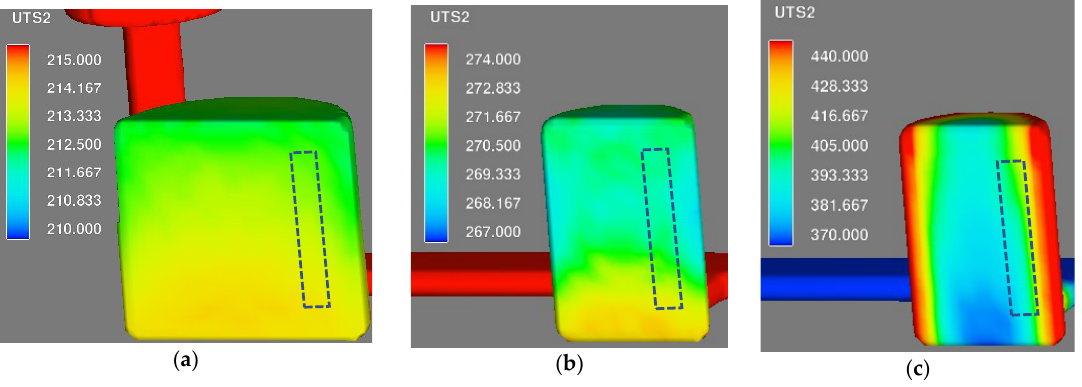
Figure 10. Distribution of ultimate tensile strength (UTS) calculated from Equations (4) and (6) for alloy B: ( a ) insulation-, ( b ) sand-, and ( c ) chill-encapsulated cylinder; the dashed lines indicate the position of the tensile bars.